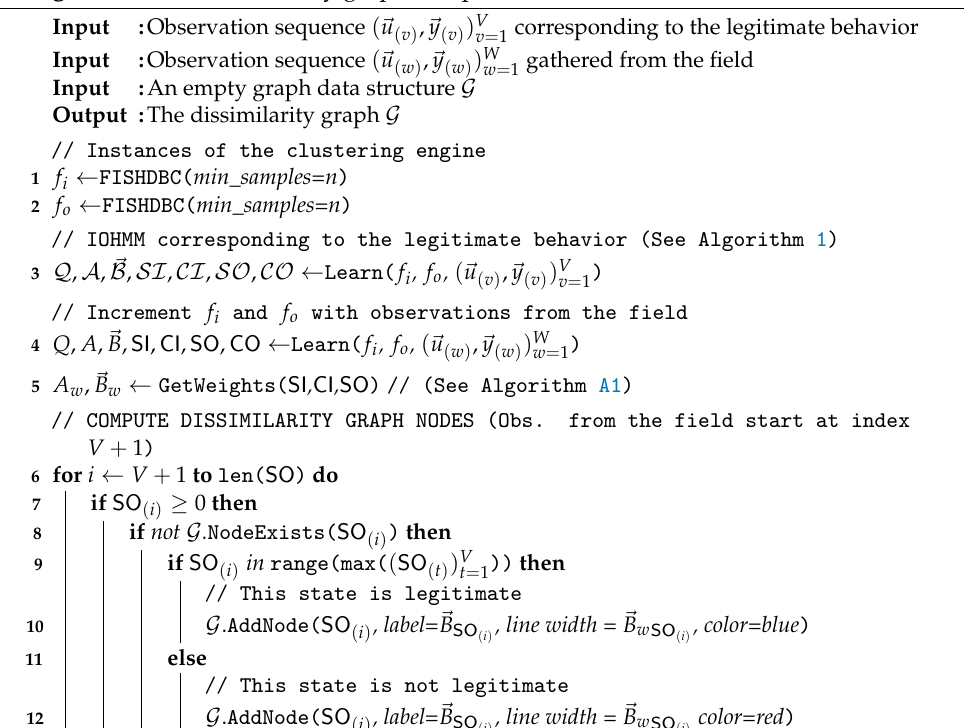
Algorithm A2: Dissimilarity graph